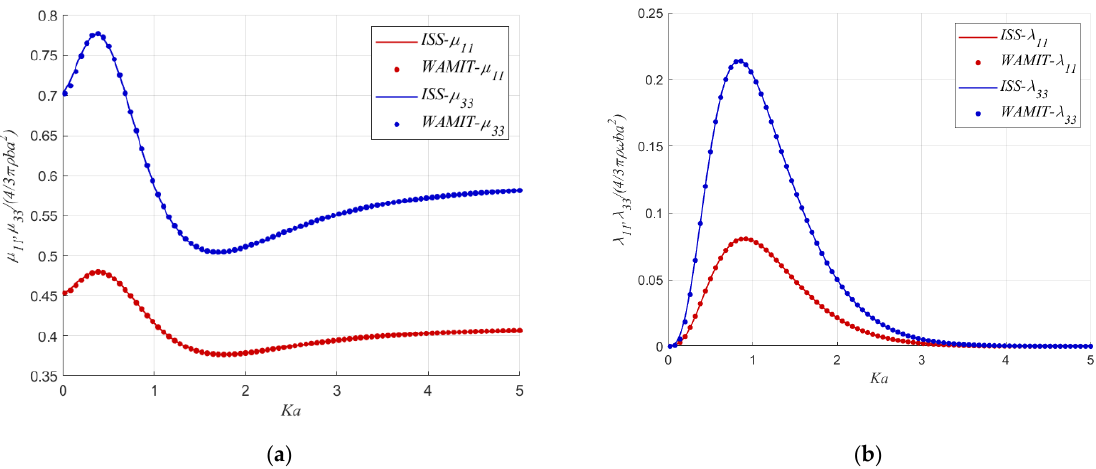
Figure 3. Normalized hydrodynamic coefficients in heave and surge for a/b = 1.25, f = 1.5a and h = 10a: ( a ) added mass; ( b ) hydrodynamic damping.